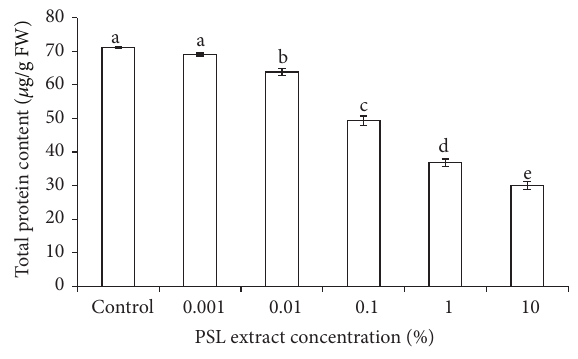
Figure 4: Effect of PSL extract on total protein content of wheat. ErrorbarsrepresentMean ± S.Dofthreedifferentexperiments.Data were subjected to one-way ANOVA analysis and differences among treatments were determined by Tukey’s test. Different letters mean statistical differences at 𝑃 < 0.05 . Figure 5: SDS-PAGE (10%) of heat proteins. Lane 1 has control and lanes 2–5 have wheat leaves treated with 0.001, 0.01, 0.1, and 10% poplar senescence leaves. M stands for marker lane.